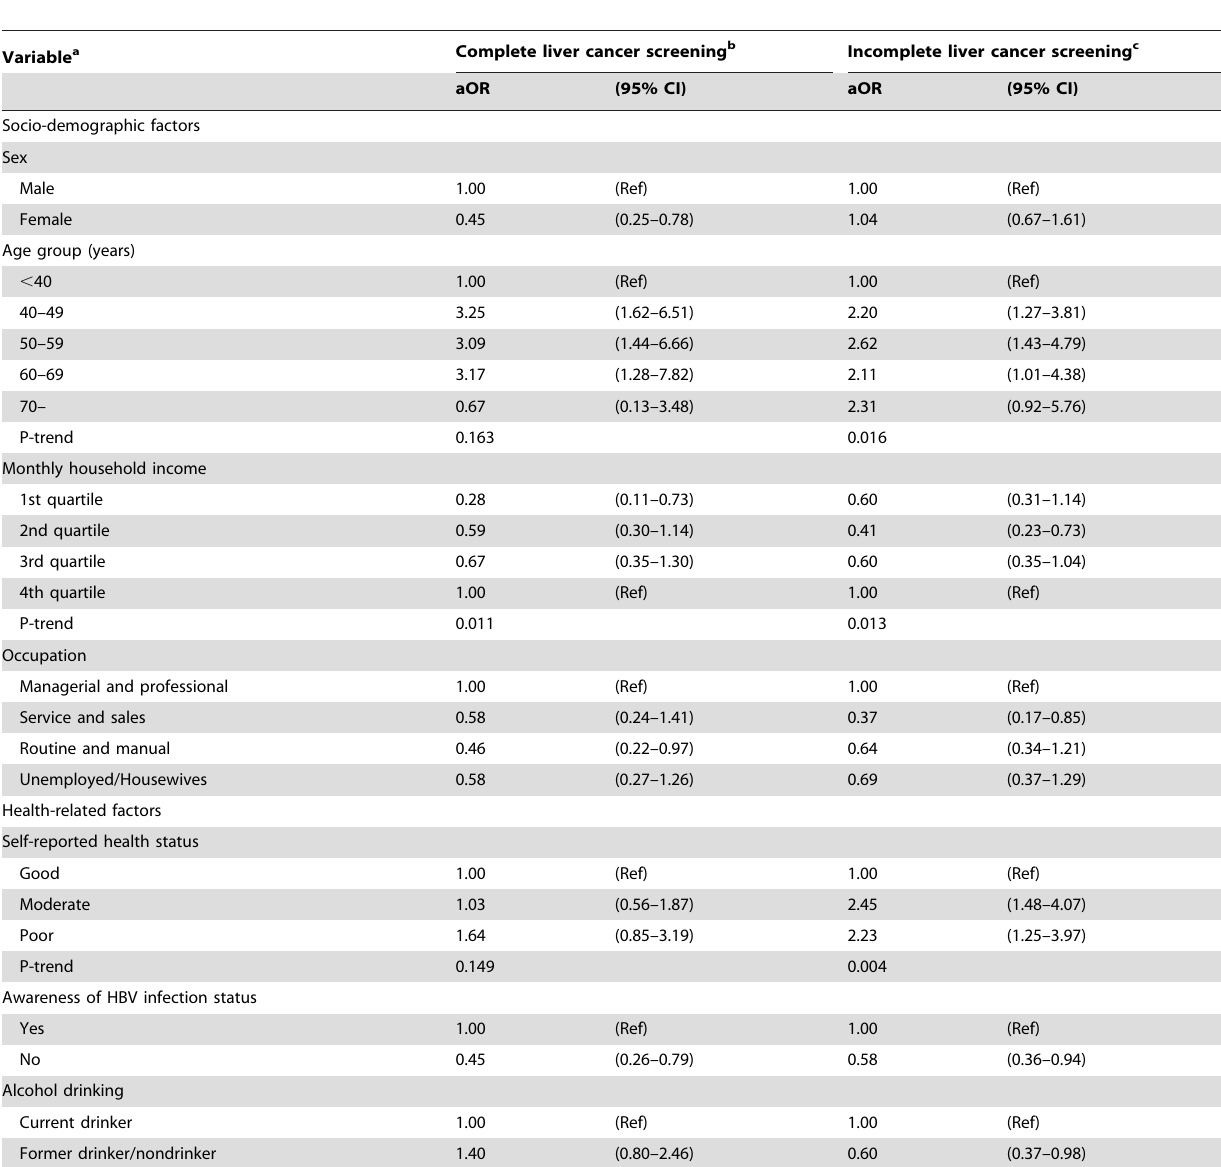
Table 3. Factors associated with complete liver cancer screening (by both ultrasonography and serum alpha-fetoprotein testing) and incomplete screening compared to never-screening by polychotomous logistic